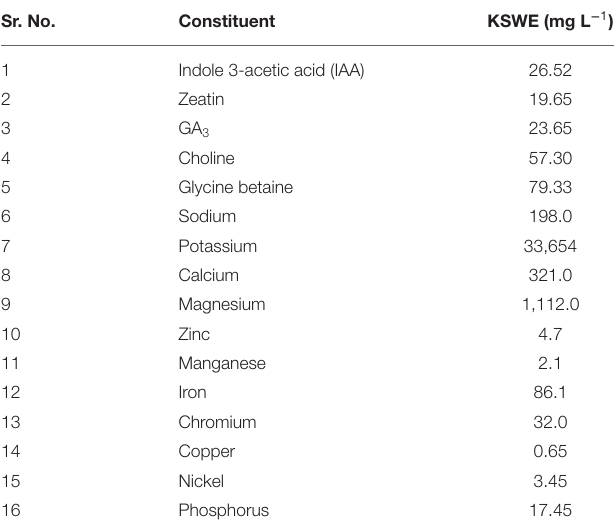
TABLE 1 | Constituents of KSWE (Singh et al., 2016). Sr.